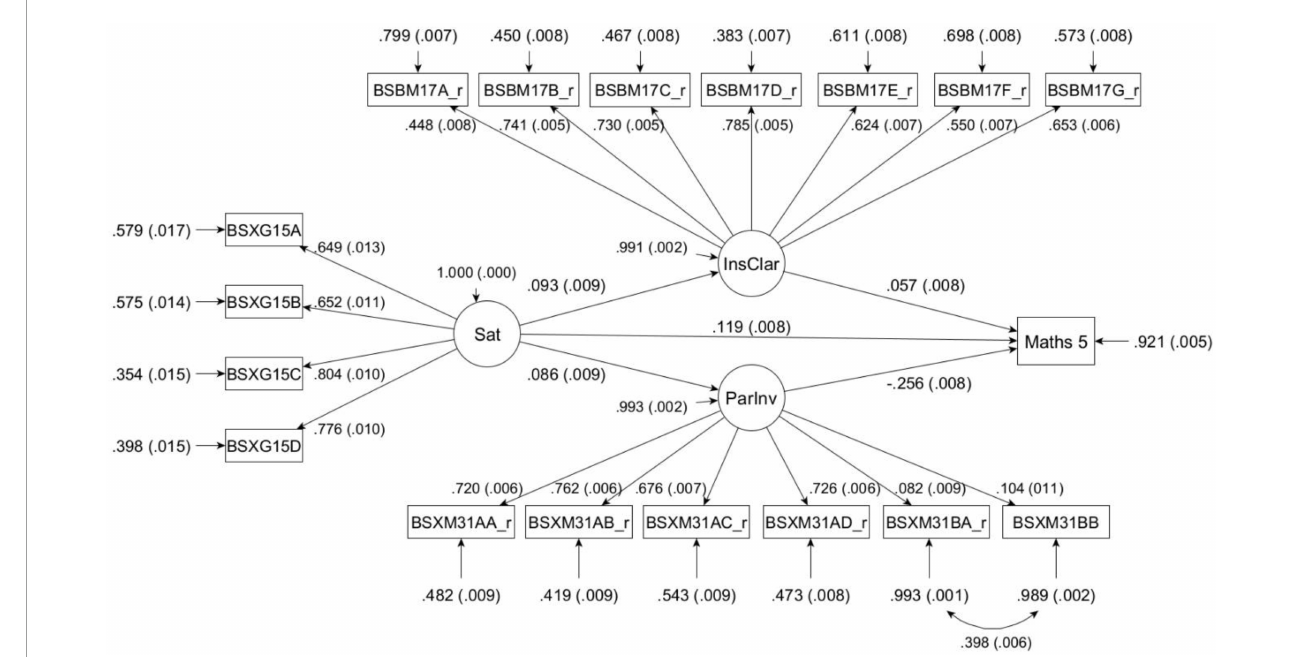
FIGURE1 Mediated structural model. Sat, satisfaction with life; InsClar, instructional clarity; Maths 5, 5th plausible value for mathematics achievement; ParInv, parental involvement.